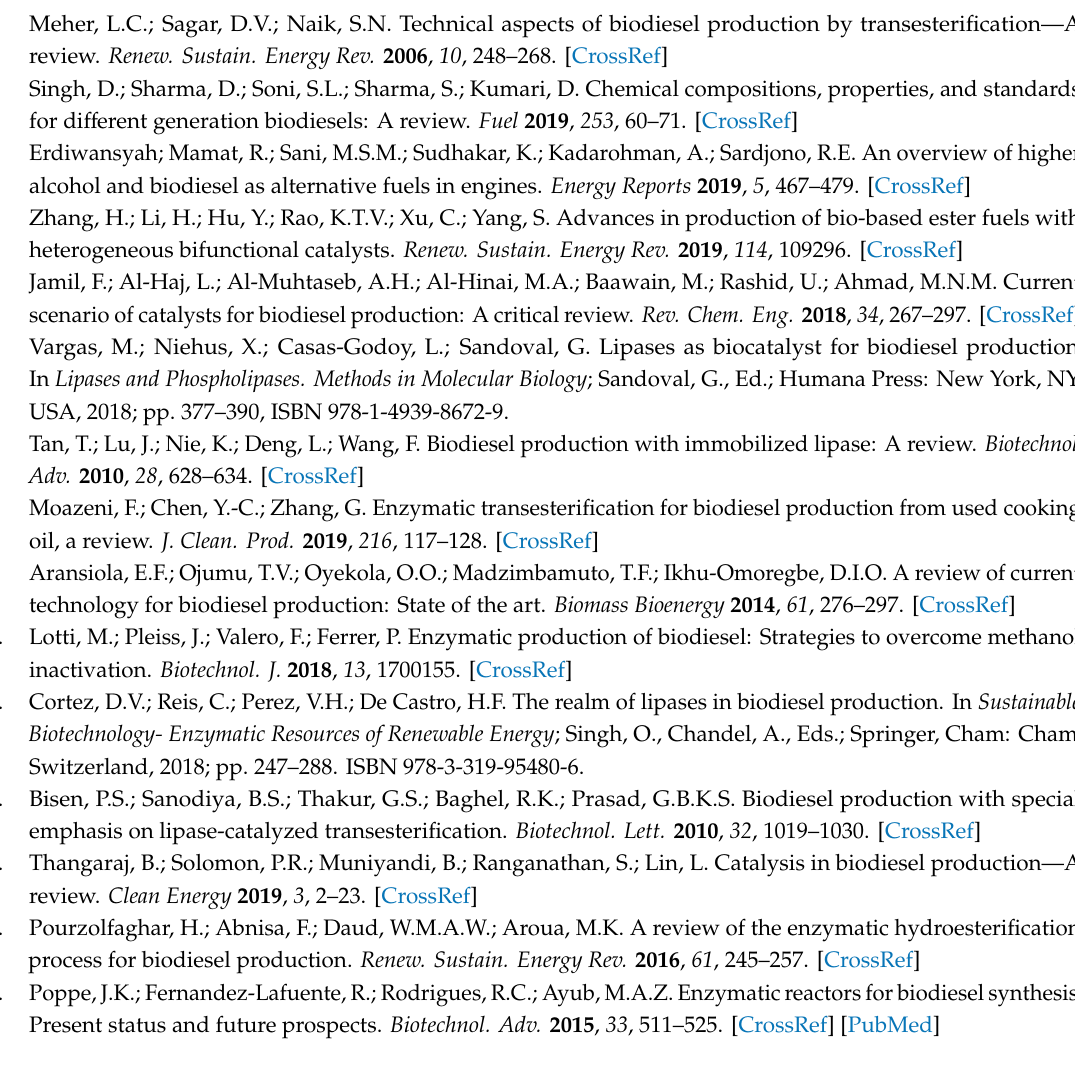
Figure S1: Adsorption profile of Eversa Transform 2.0 treated with polyethyleneimine on silica magnetic nanoparticles (SMNPs) functionalized with octyl and amine groups; Figure S2: Profile of inactivation of liquid Eversa ® Transform 2.0 at 60 ◦ C and pH 7.0 (100 mM sodium phosphate bu ff er) using an enzyme concentration of 5 mg protein / mL; Table S1: Experimental conditions (enzyme load and water content) for transesterification reactions using liquid and immobilized